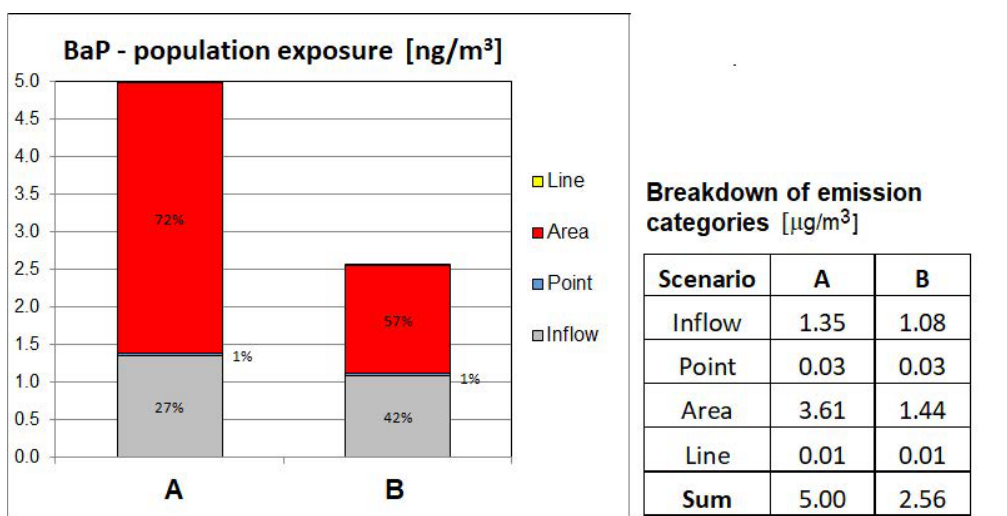
Figure 5. Modifications of PM 2 . 5 exposure.